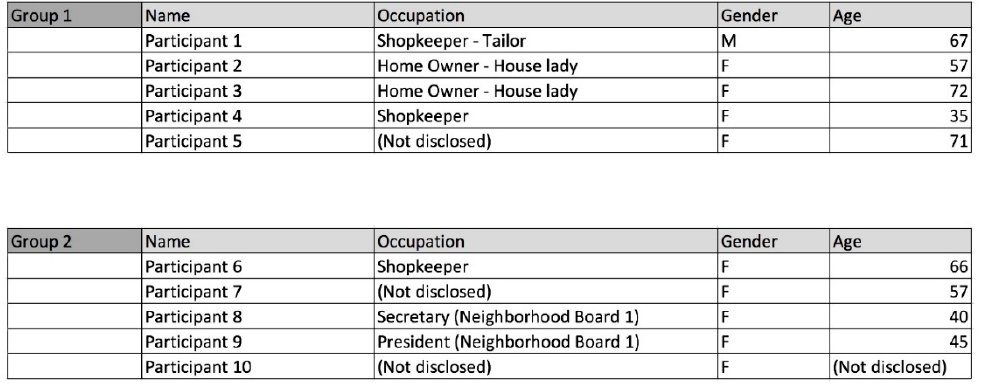
Figure 5. Occupation and demographic characteristics of the participants of the community mapping exercise.